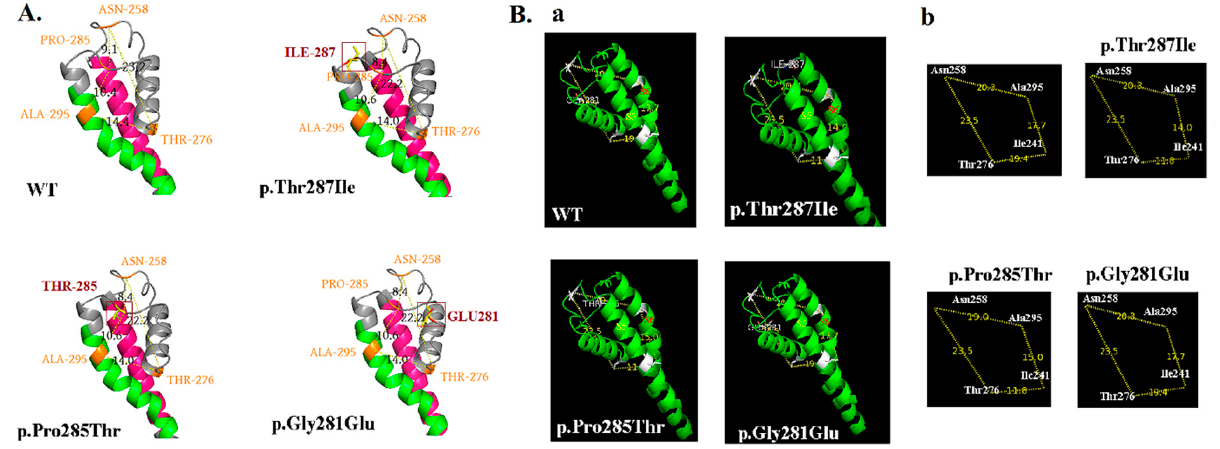
Figure 8. Schematic representation of the KCNQ2 subunit with the position of the mutations of p.Thr287Ile. The predicted 3D model of the KCNQ2 channel protein (c5vmsA_.1.pdb) was then used to analyze the structural differences between KCNQ2 WT and mutations by using Swiss-PdbViewer and PyMOL, respectively. Mutation (p.Thr287Ile, p.Gly281Glu and p.Pro285Thr) sites at the selectivity filter (SF) might alter accessibility for potassium ions through the channels. The p.Thr287Ile, p.Gly281Glu and p.Pro285Thr are located in the SF of the pore domain and cause the KCNQ2 protein configuration of pore domain change according to the molecular model. ( A ) The pore change was determined by calculating the distances from Asn (p.258) to Pro (p.285), Pro (p.285)